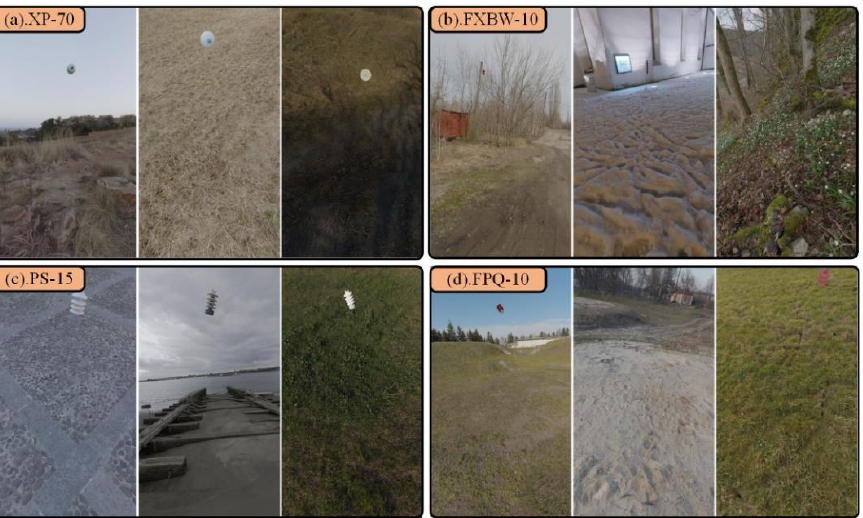
Figure 18. Example of the synthetic dataset. ( a ) Synthesis image of XP-10; ( b ) synthesis image of FXBW-10; ( c ) synthesis image of PS-15; ( d ) synthesis image of FPQ-10.